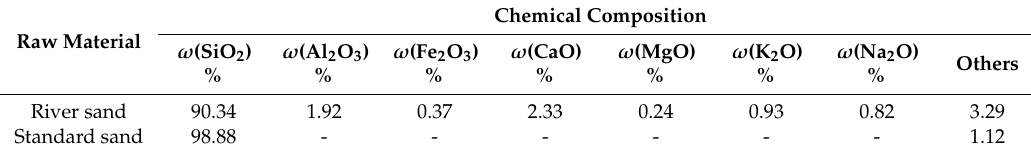
Table 1. Chemical composition of raw materials.